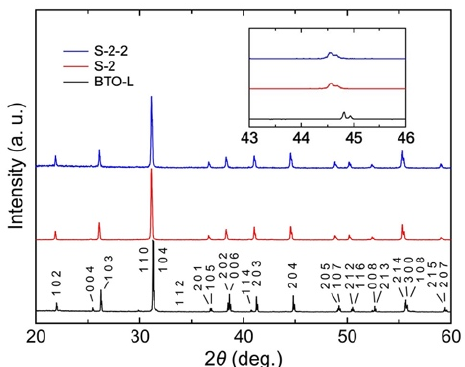
Figure 2. XRD patterns of the polycrystalline 6H-BaTiO 3 − x and 6H-BaTiO 3 − x H x . The S-2 sample was synthesized by the Mg reduction twice at 1000 °C for 10 h, which was further subject to hydride reduction with CaH 2 at 520 °C for 120 h to produce S-2-2, in contrast to BTO-L prepared by H 2 reduction at 1450 °C for 1 h.